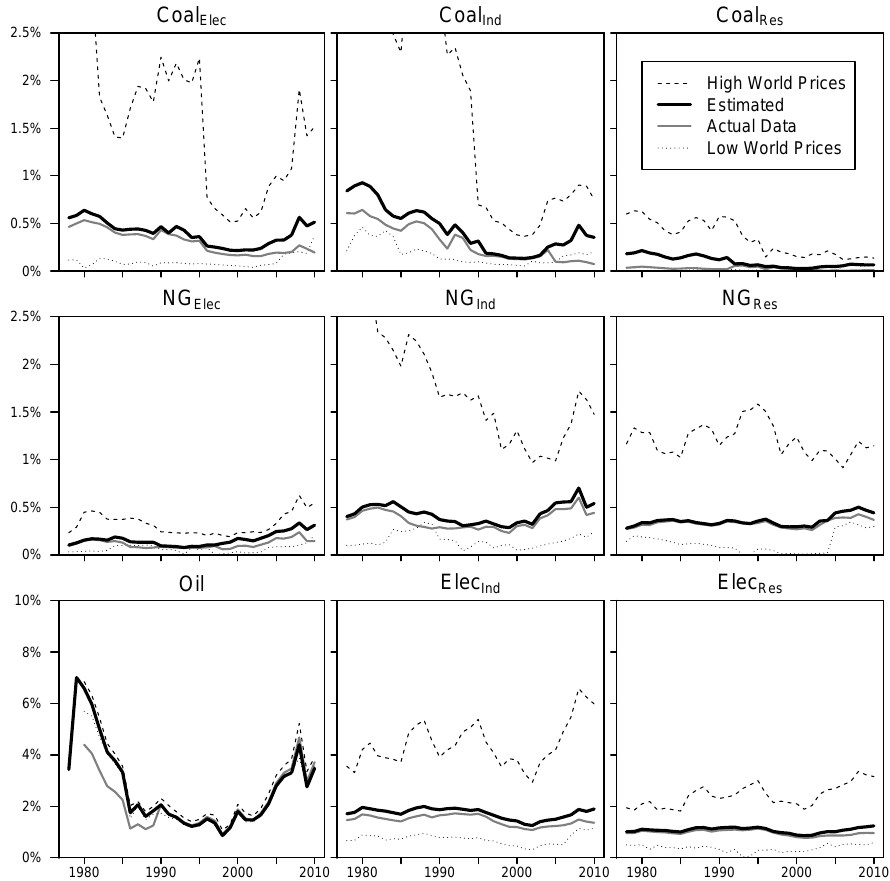
Figure 3. The expenditures on energy for the aggregate 44 countries in the dataset as a percentage of GDP ( f e ,GDP ) for each of the nine major energy commodities. Estimated = assumes reasonable prices for countries with no price data for certain commodities. Low/high world prices = assumes the lowest/highest price in the dataset for each commodity is applied to all countries. Actual data = calculation using available data in IEA dataset with no substitutions. For some years and commodities, the low world prices calculation is greater than the actual dataset because sometimes, there are no “actual” price data. Thus, one calculates zero expenditures for that country, year and commodity, and when applying the low world prices’ (non-zero) worldwide price to this situation, the energy expenditure is now greater than zero. NG = natural gas, Elec = electricity, Ind = industrial and Res = residential, such that, for example, NG Ind is natural gas purchased by the industrial